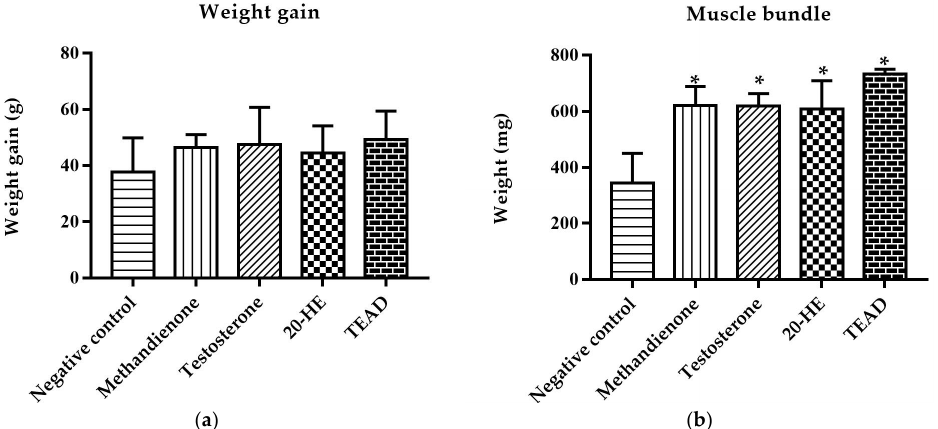
Figure 8. Weight gain of treated groups ( a ). No significant differences within groups, p = 0.54. Mass of gastrocnemius and soleus muscles of treated groups ( b ). * : Significantly different from the nega- tive control group at p < 0.001.